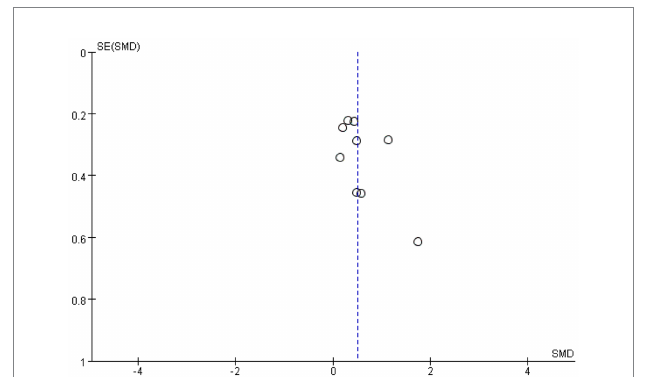
FIGURE 9 Funnel plots of upper limb.